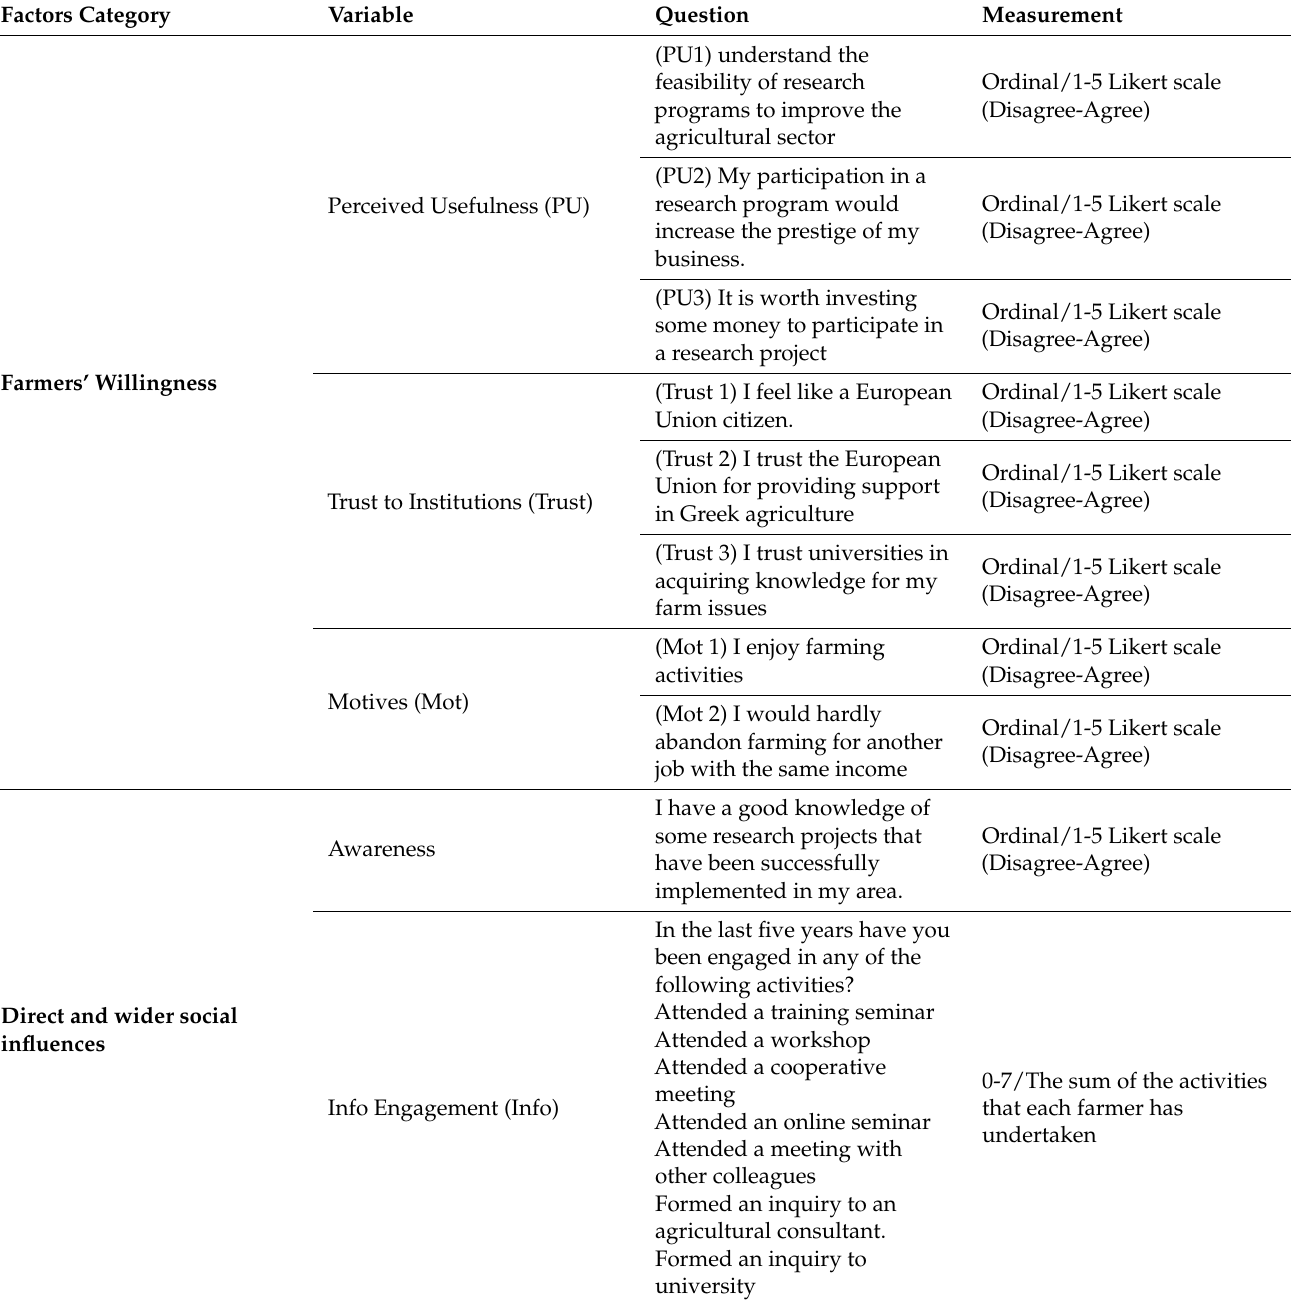
Table 1. The explanatory variables of the